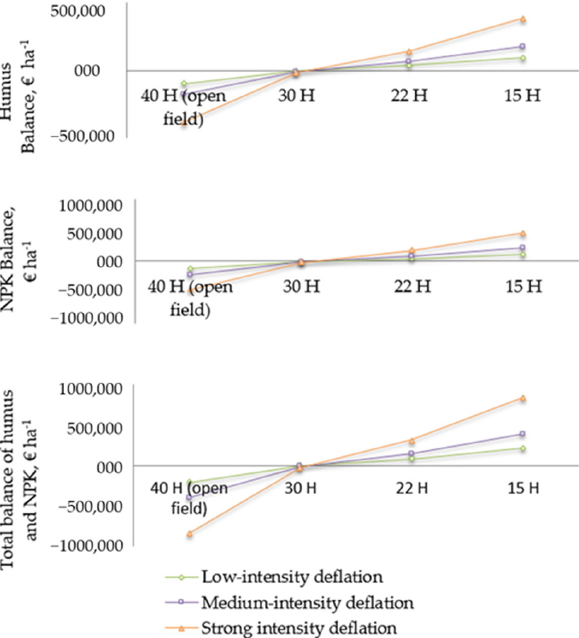
Figure 3. Dynamics of the annual anti-deflationary effect of protective forest stands that have reached the design height (taking into account the climate factor), determined by the replacement cost of humus, NPK nutrients, and their total amount, depending on the interband spaces at different intensity of deflationary